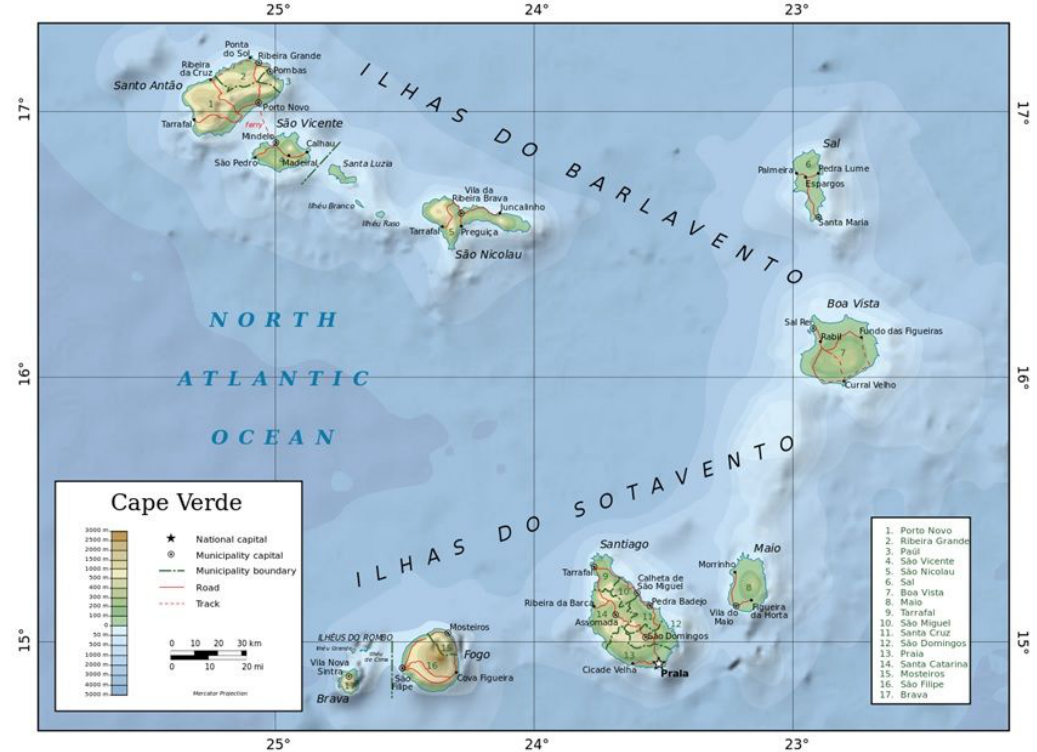
Figure 1. Situation of the Cape Verde Archipelago. Source: Adapted from Wikimedia Commons